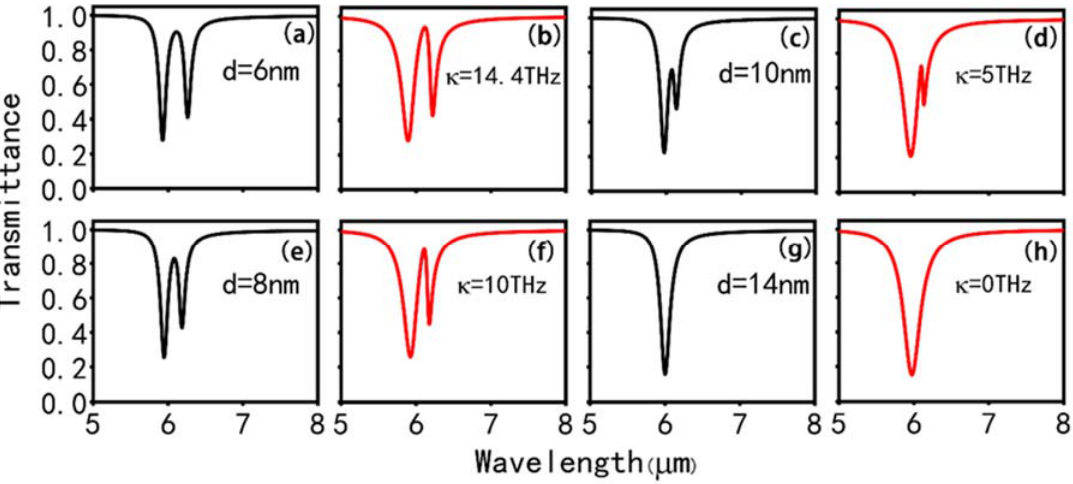
Figure 4. ( a , c , e , g ) the simulated transmission spectra of the PIT metasurface with different coupling distances d . ( b , d , f , h ) corresponding theoretical transmission spectra with different coupling coefficients κ .